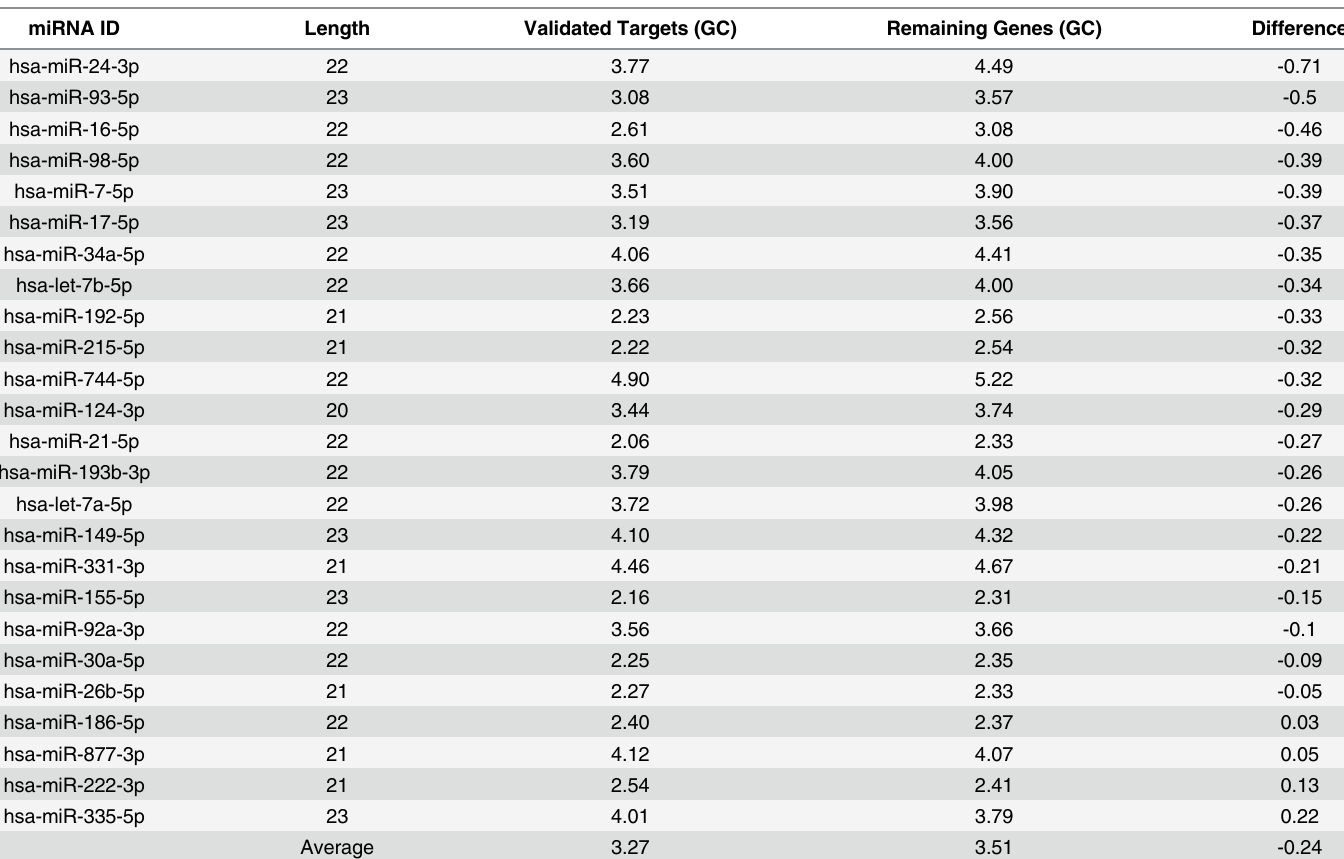
Table 1. Contribution of miRNA non-seed region to gene silencing. The list of putative targets perfectly matching the miRNA seed region (positions 2 – 8) was intersected with a list of experimentally validated miRNA targets [23]. Genes present on both lists were placed in the ‘ Validated Targets ’ group, while genes predicted to interact with miRNA but which have not been experimentally confirmed, were placed in ‘ Remaining Genes ’ group. The GC content in the positions 8 – 15 was calculated for both groups and compared. The difference was calculated by subtracting values of the ‘ remaining ’ group from the values in the ‘ validated ’